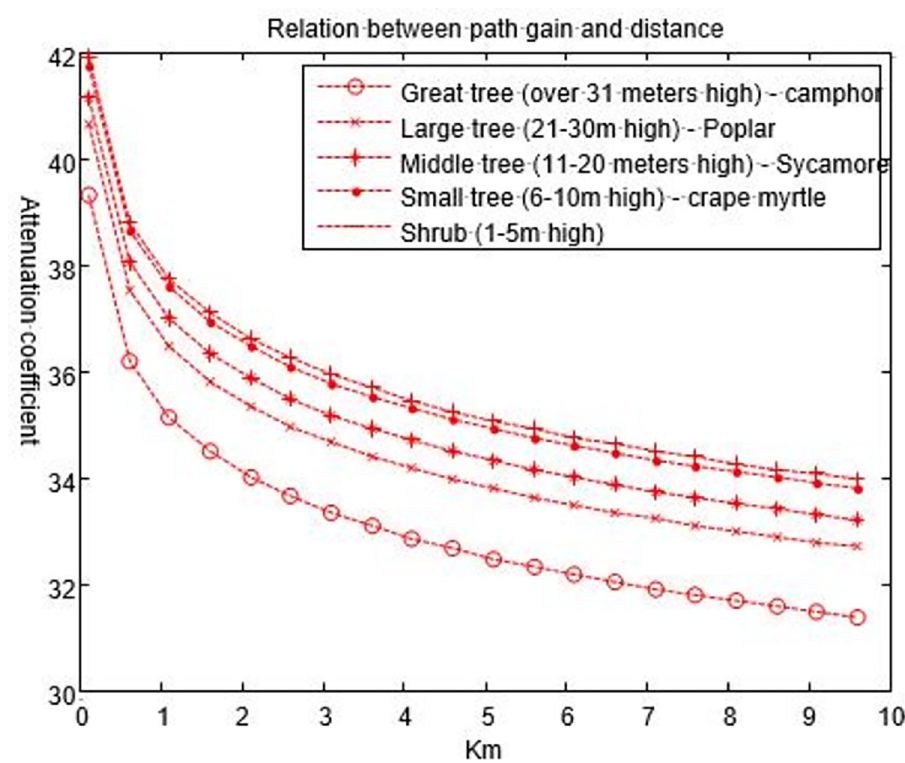
Fig 11. Relationship between the electromagnetic wave path gain and the distance with different vegetations in the free space of the base station.